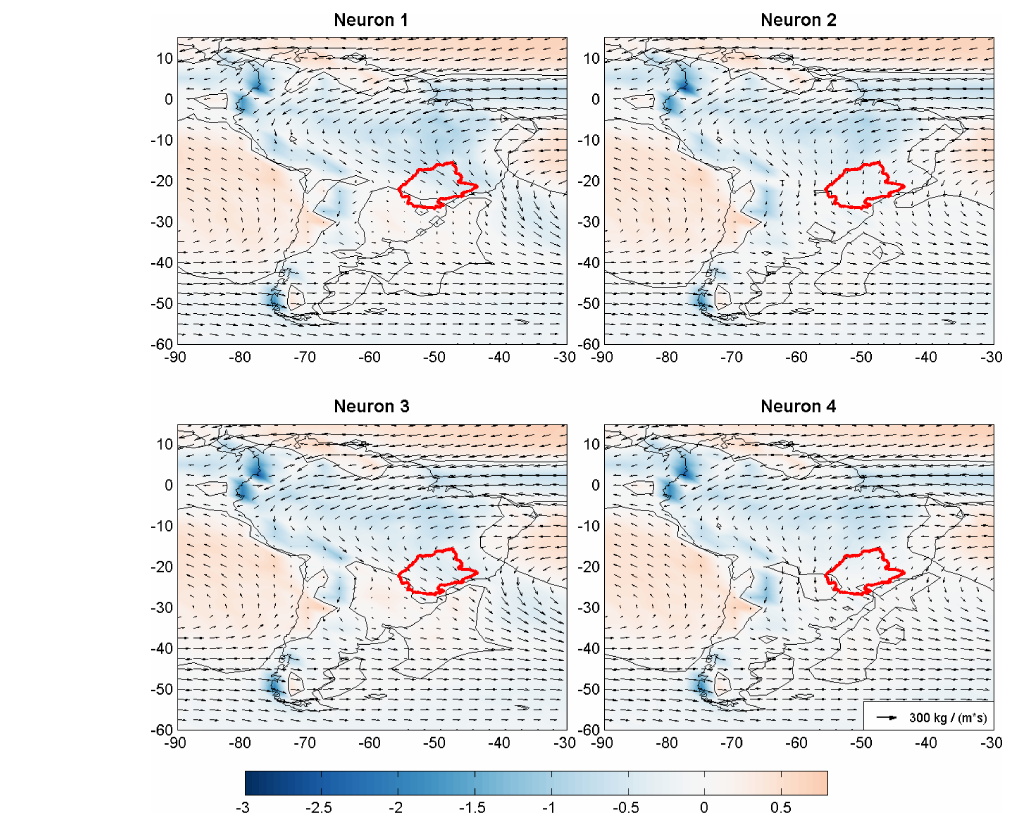
Figure 4. Vertically integrated moisture fluxes (kg(ms) − 1 , shown by the arrows) and associated divergence field (10 − 4 kg(m 2 s) − 1 ) aver- aged over each neuron class. The red contour line shows the Upper Paraná River basin. The contour for the divergence field equal to zero is also shown.